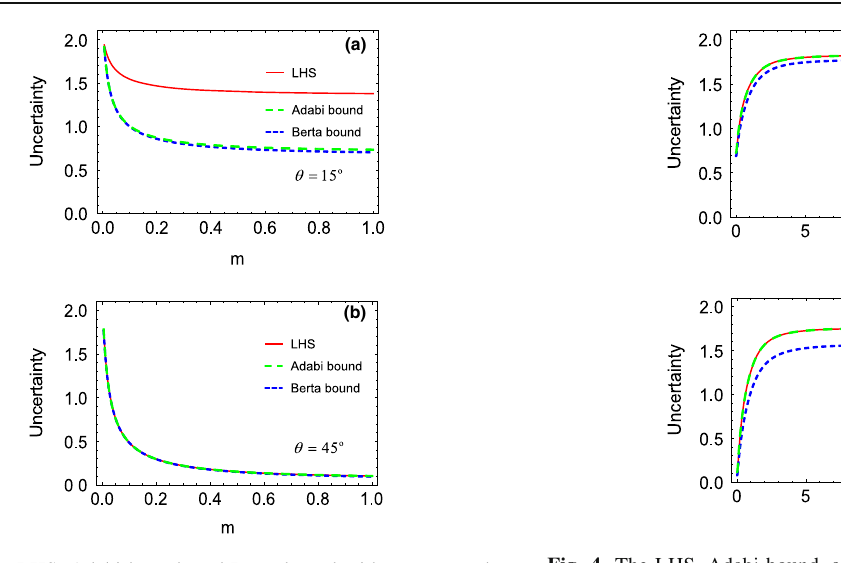
Fig. 3 The LHS, Adabi bound, and Berta bound with respect to the particlemass m ofthescalarfieldwhenconsideringtwocomplementary observables (σ x ,σ y ) . ε = ε max = ( 4 / m 2 − 1 )/ 2, σ = 2, (cid:14) = 2, and μ = μ = 0 . 1 A B